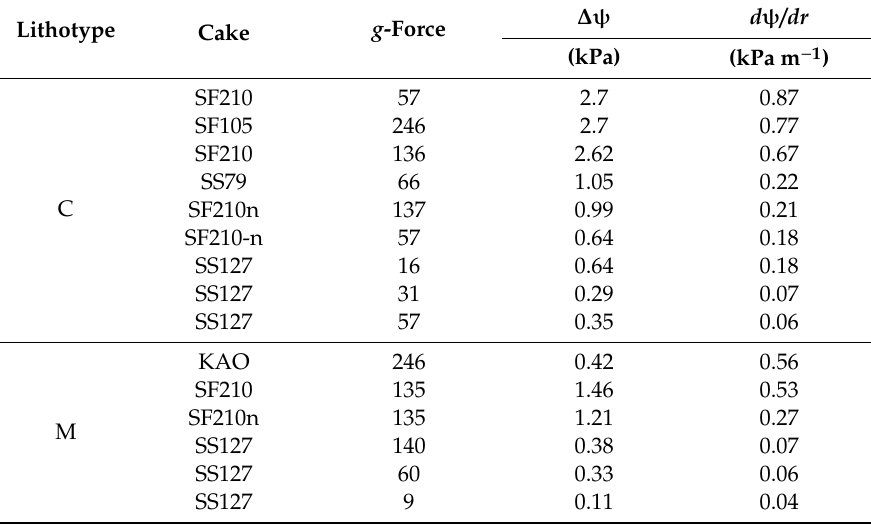
Table 3. Matric potential gradient, d ψ / dr , calculated by using the KOPCEN code. Lithotype